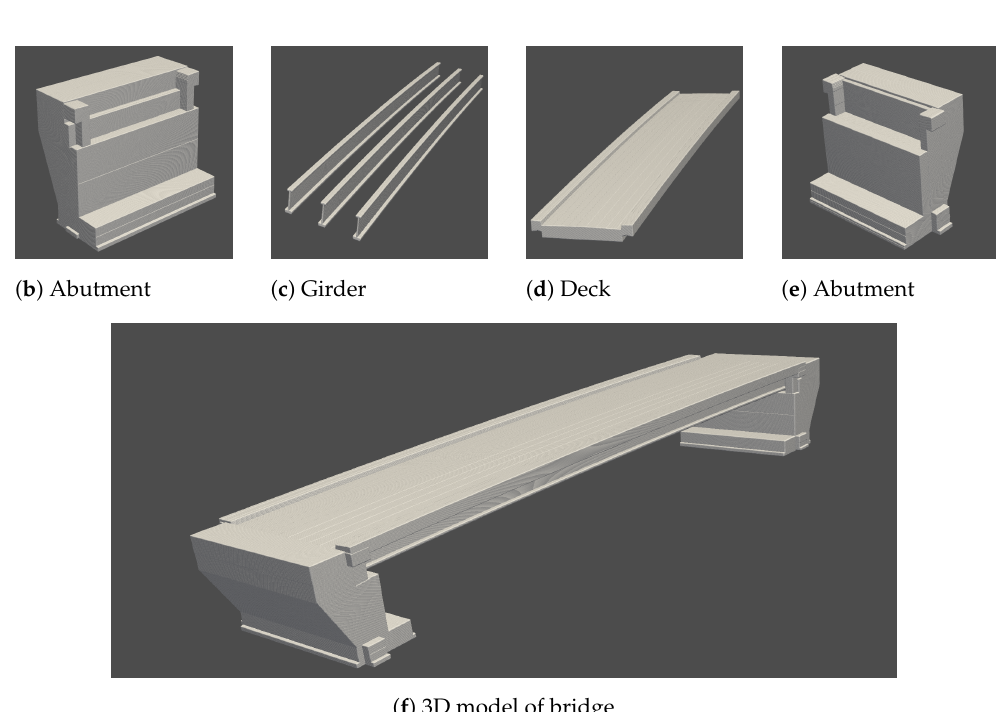
Figure 9. 3D reconstruction of Gaskugel bicycle bridge over the Dreisam river in Freiburg. ( a ) is one of the eight 2D plans used to reconstruct some parts of the 3D model of the bridge. ( d ) is a 3D reconstruction of the concrete superstructure of the bridge. ( c ) is a 3D reconstruction of the metallic reinforcement of the bridge. ( b , e ) are 3D reconstructions of the abutments of the bridge. ( f ) depicts the fused parts of the reconstructed 3D model of the Gaskugel bicycle bridge.